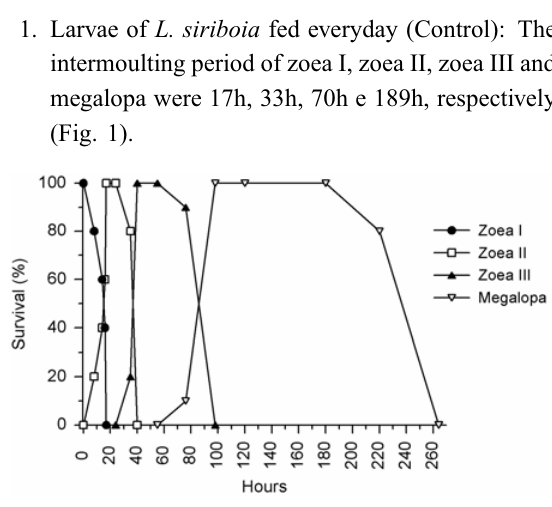
Fig. 2 – Survival (%) and intermoulting period (hours after hatching) of Lepidophthalmus siriboia larvae reared in the laboratory and sub- mitted to an initial feeding period. In this treatment, they were fed during 1 day only.